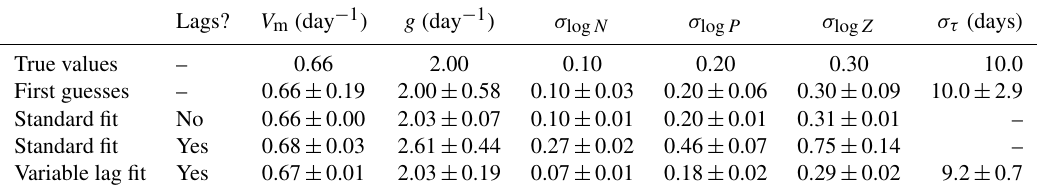
Table A1. True parameter values and means ± 1SD of estimates over 20 simulated data sets, using a standard fit method and a variable lag fit method (see Eq. A3). Three years of weekly NPZ data were simulated using the true values (first row) for the maximum nutrient uptake rate V m , zooplankton grazing rate g , residual standard deviations σ log N,P,Z , and time lag standard deviation σ τ (for experiments with lags imposed). With no time lags, the standard fit accurately recovers the true parameter values (third row), but with time lags (fourth row) the standard grazing rate estimates are biased and imprecise, while the residual variances have strong positive bias as they are forced to account for the time lag errors. The variable lag fit avoids these biases and accurately partitions the variance between residual error and time lag error (fifth